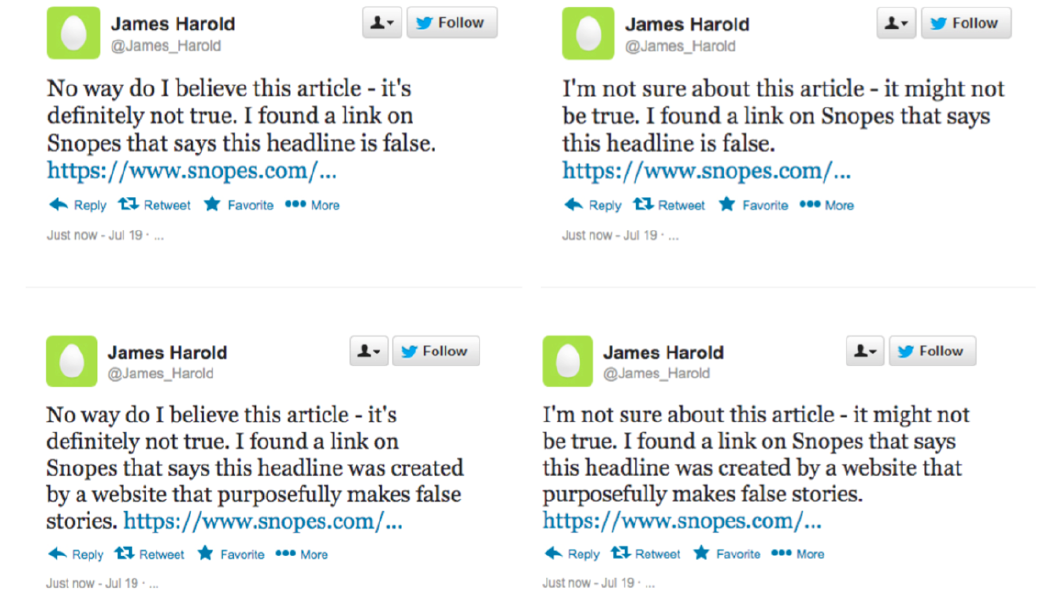
Figure 2. Corrective message conditions. Note: Clockwise, from top left: direct, simple; hedged, simple; hedged, detailed; direct,